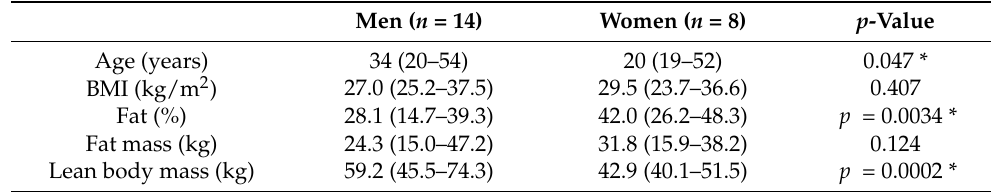
Table 2. Characteristics by gender of 22 adults with PWS treated with GH for a median of 20 years. Results are shown as medians and